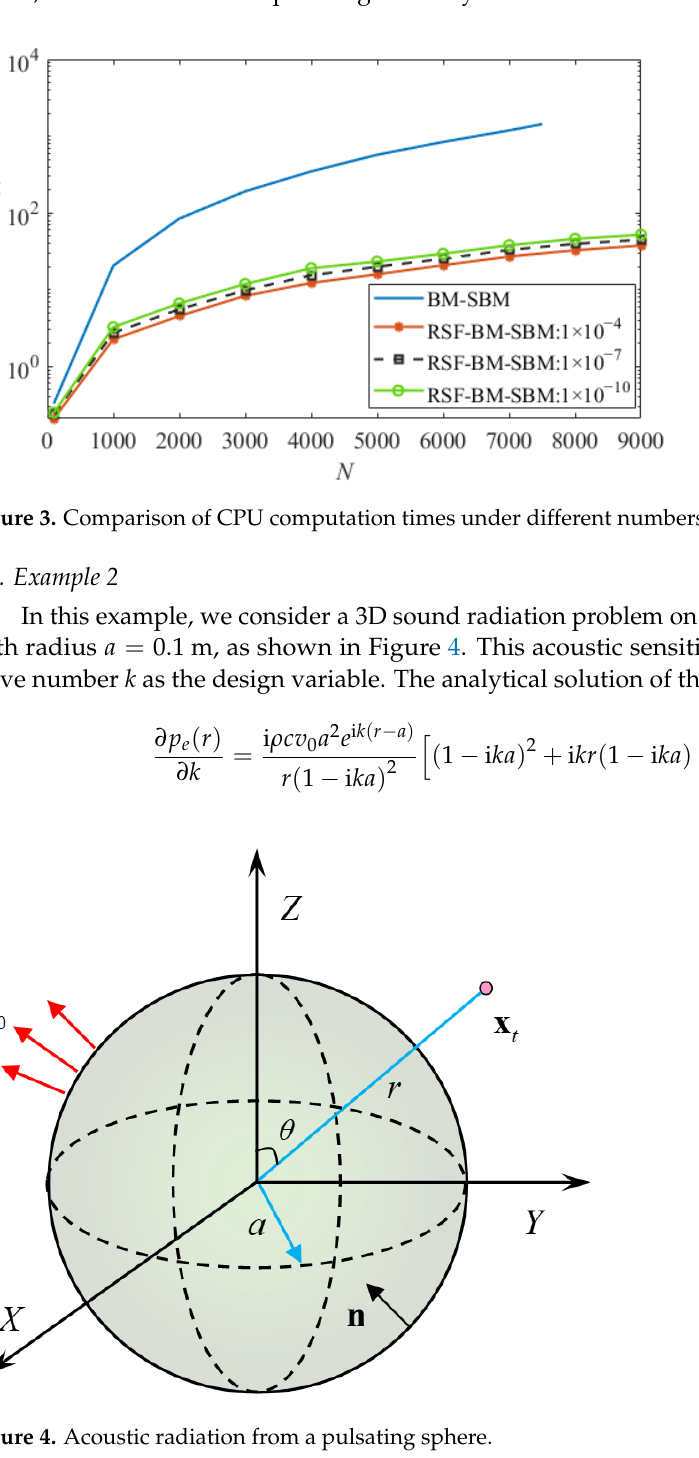
Figure 2. The RRMSEs of the RSF ‐ BM ‐ SBM and conventional BM ‐ SBM: ( a ) real part; ( b ) imaginary part.